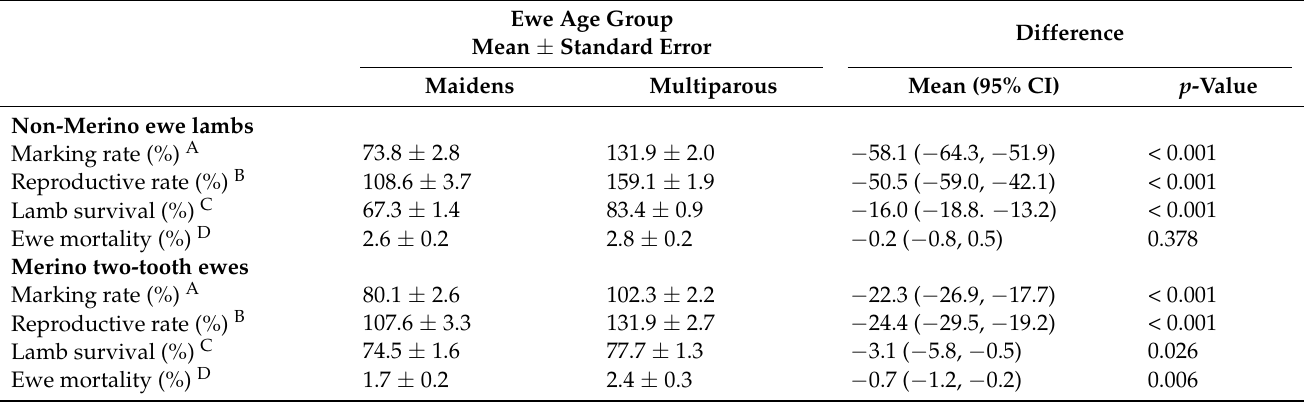
Table 4. Comparisons between maiden and mature multiparous ewes for reproductive rate, marking rate and lamb survival with mean ± standard error, 95% confidence interval (95% CI) for the difference and non-parametric related samples Wilcoxon signed-rank test. Ewe Age Group Mean ± Standard Error